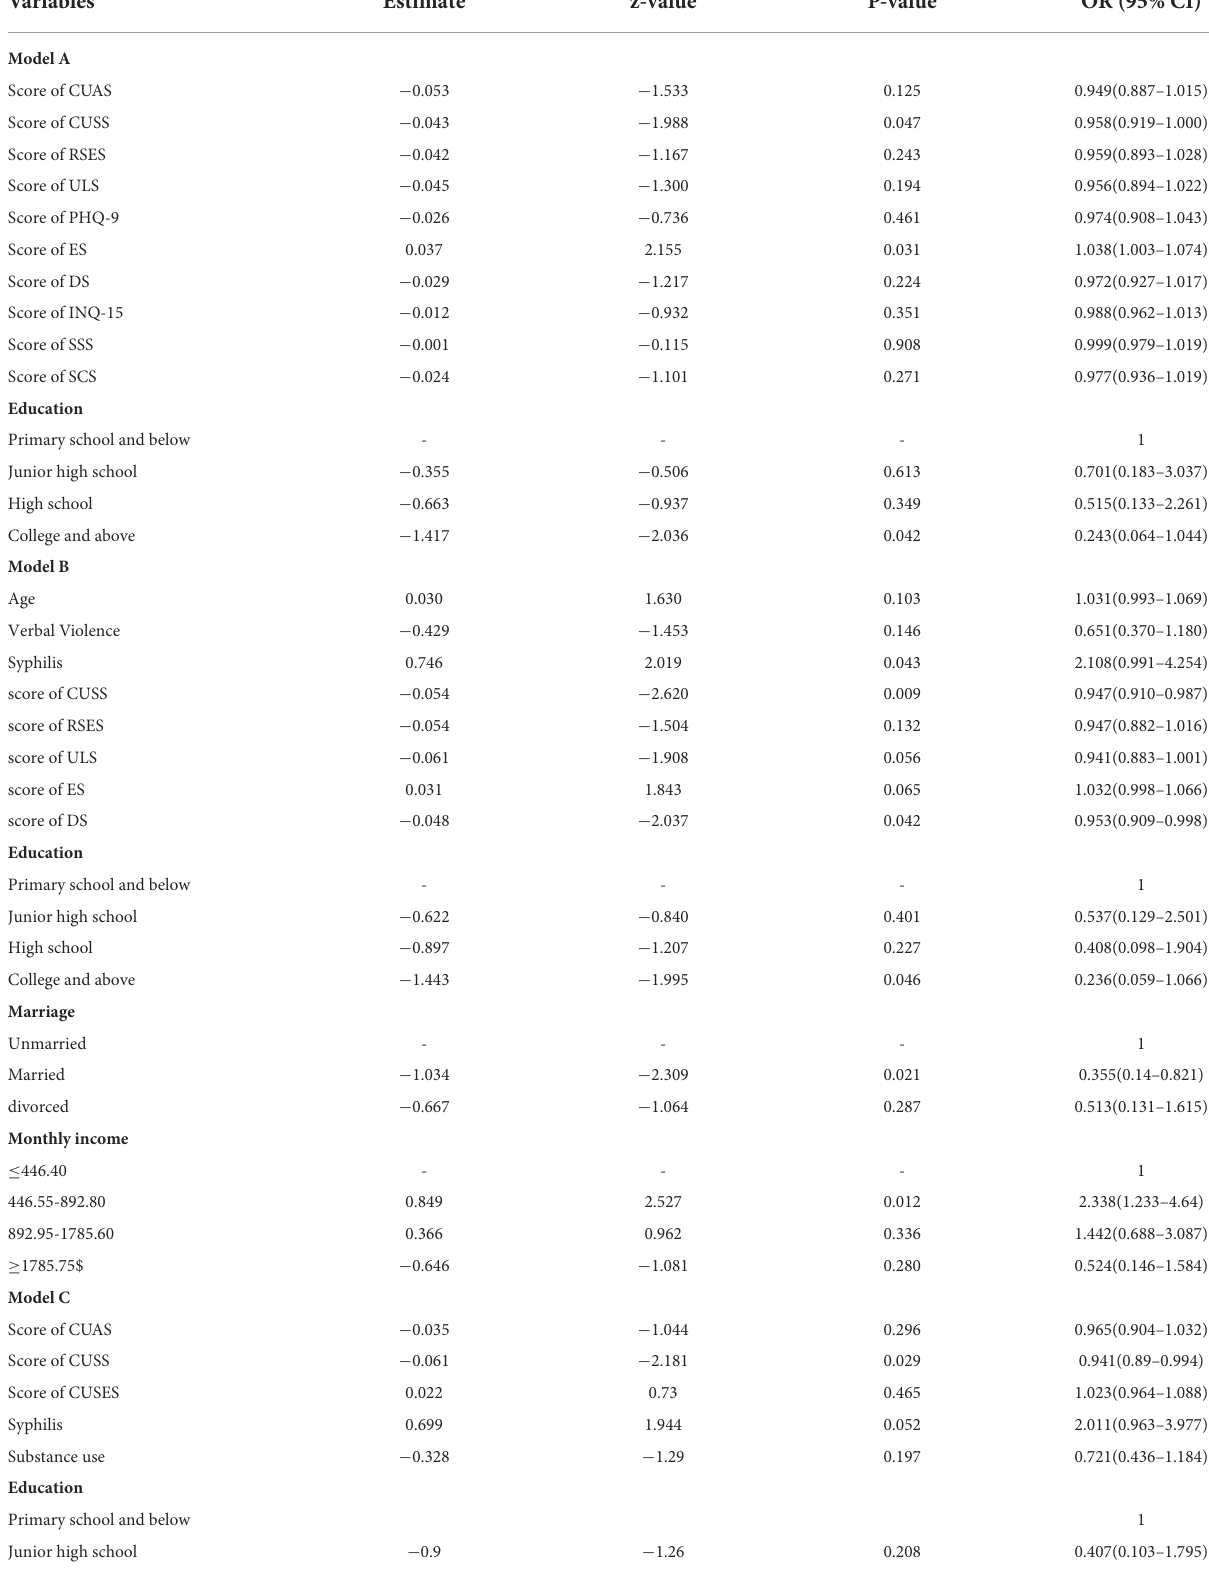
TABLE 2 Models established by 3 variable selection